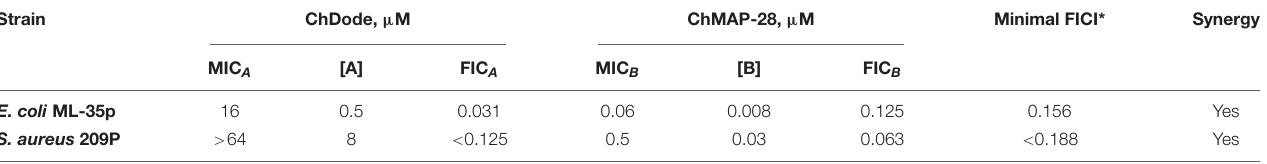
TABLE 2 | Synergy between goat cathelicidins ChDode and ChMAP-28. Strain ChDode, µ M